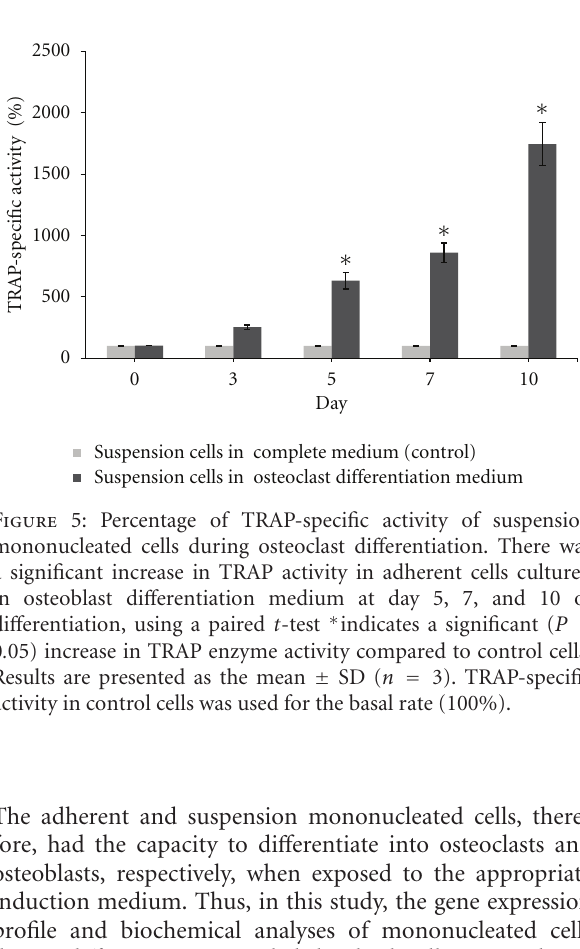
Figure 4: Percentage of ALP-specific activity of adherent mononu- cleated cells during osteoblast di ff erentiation. There was signifi- cantly increased ALP activity in adherent cells cultured in osteoblast di ff erentiation medium at days 7, 10, and 14 of di ff erentiation, using a paired t -test ∗ indicates a significant ( P < 0 . 05) increase in ALP enzyme activity compared to control cells. Results are presented as the mean ± SD ( n = 3). ALP-specific activity in control cells was used for the basal rate (100%).